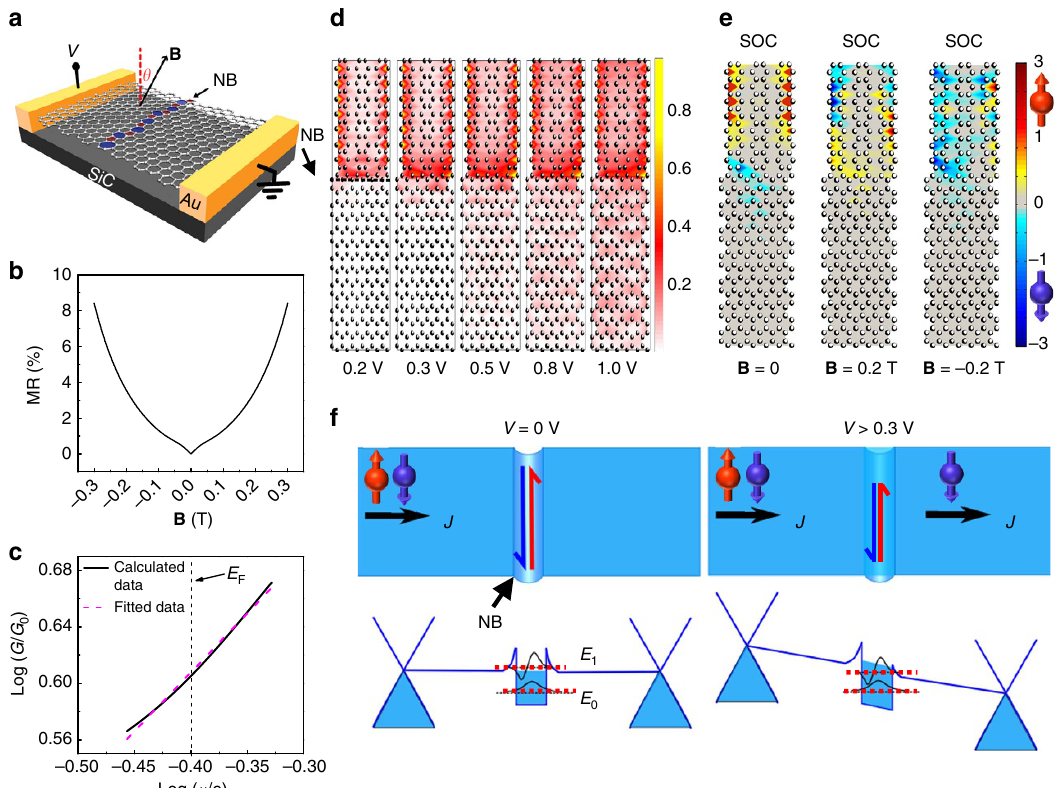
Figure 3 | MR and spin-filtering effect of graphene containing a single NB. ( a ) Schematic drawing of the model used. ( b ) MR of graphene containing a single NB calculated with an in-plane magnetic field from using the NEGF method. ( c ) Calculated conductance G / s m ð Þ as a function of m under G 0 . The best fit of s ( m ) p m a gives a E 0.839 o 1. This sublinear dependence is consistent with the positive MR criterion from the a 4T field with G 0 ¼ 2 e 2 h Kubo–Greenwood formula. ( d ) Charge distribution at different bias voltages calculated from NEGF simulations indicating the presence of a transport gap below 0.3eV and a high charge density along the NB. The bias voltage is applied from the top to the bottom and the current passes through the NB. The colour intensity indicates the relative magnitude of charge density. ( e ) Spin density distribution in the z direction (perpendicular to graphene plane) under a bias voltage of 0.4V calculated from NEGF simulations to demonstrate the spin-filtering effect due to the localized state of a NB and SOC of 0.1meV at ripples. The sign indicates the orientation of the spins and the unit of intensity is 7 (cid:2) 10 (cid:3) 26 : m (cid:3) 2 . ( f ) Schematic illustration of electrical transport and spin-filtering effect due to localized state of NBs and SOC at